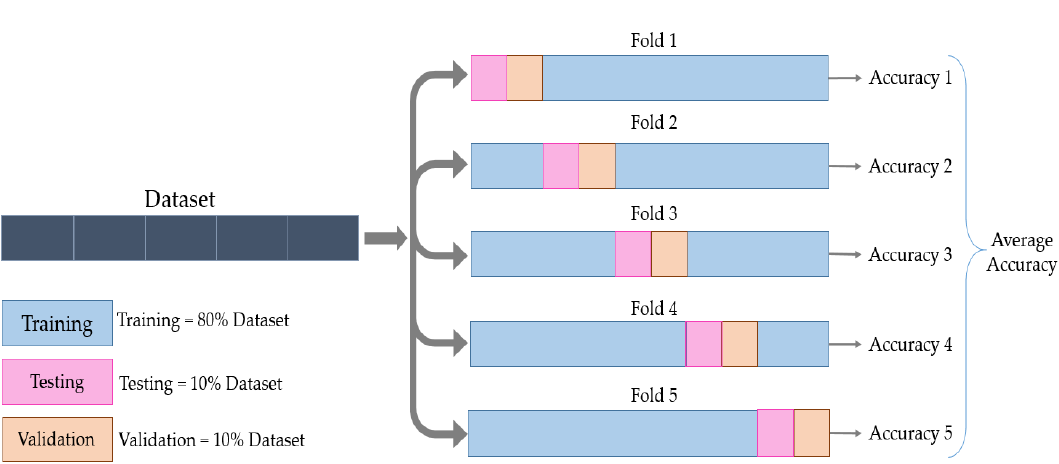
Figure 4. Visual representation of the training, test, and validation split using cross-validation.